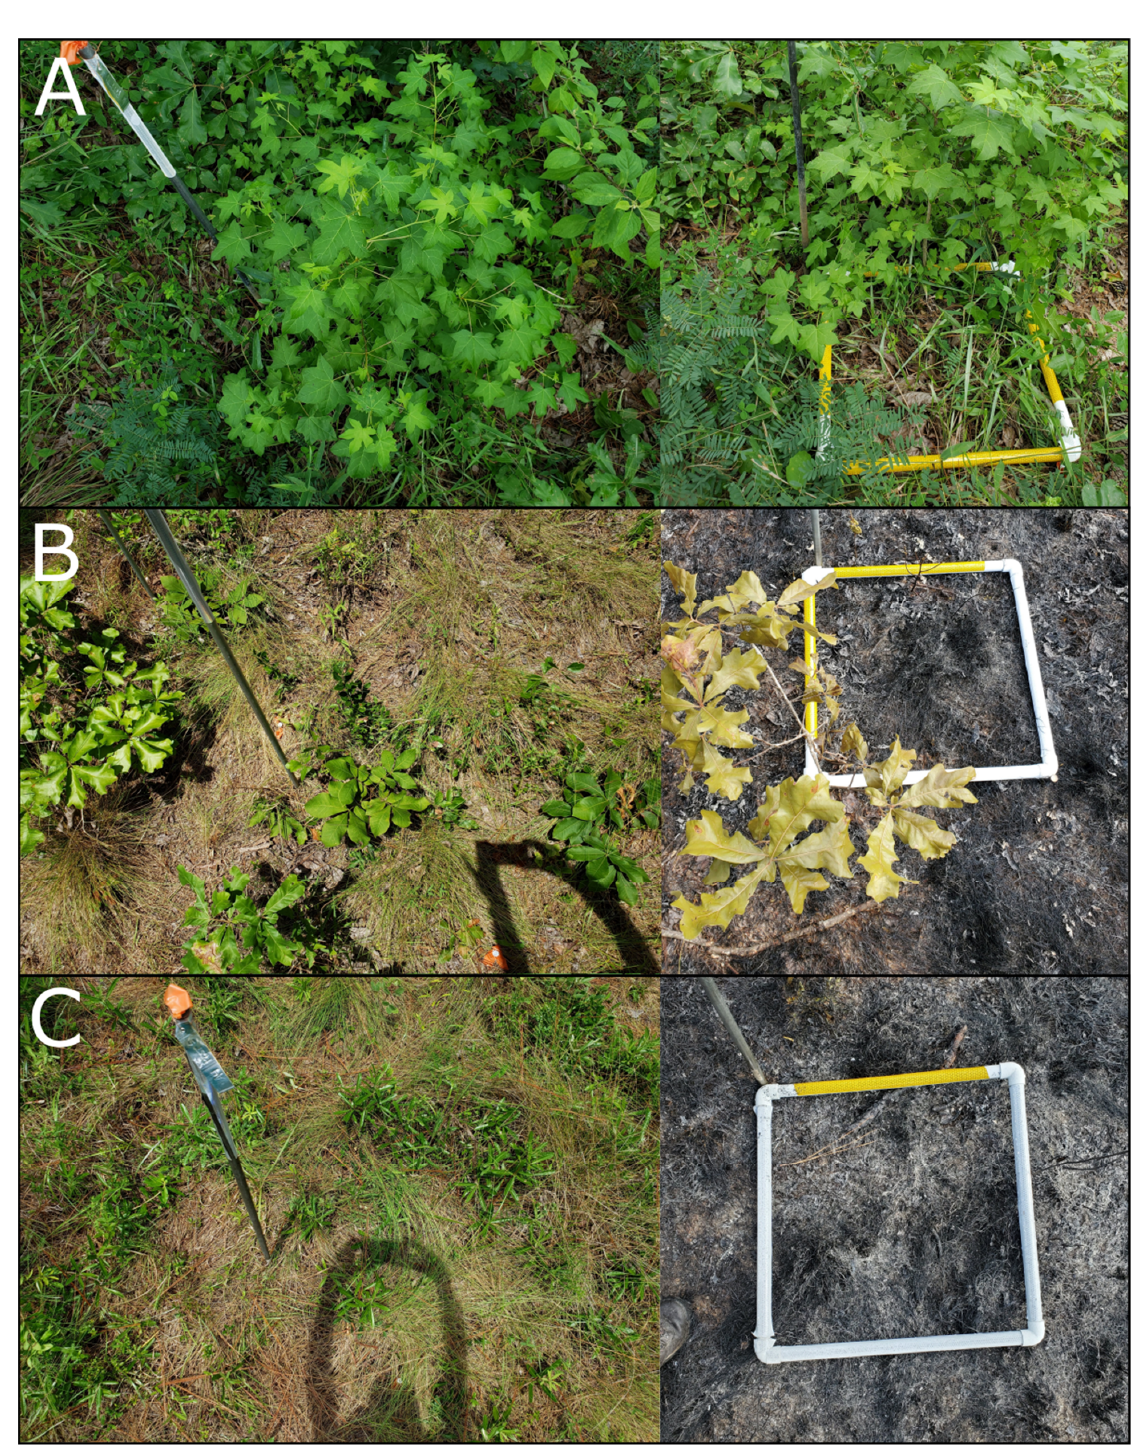
Figure 6. Fuel consumption in three plots. Photos on the left show pre-burn fuel and photos on the right show fuel remaining post-burn. ( A ) is a plot with no fuel consumption, ( B ) is a plot with moderate consumption, and ( C ) is a plot with complete consumption.